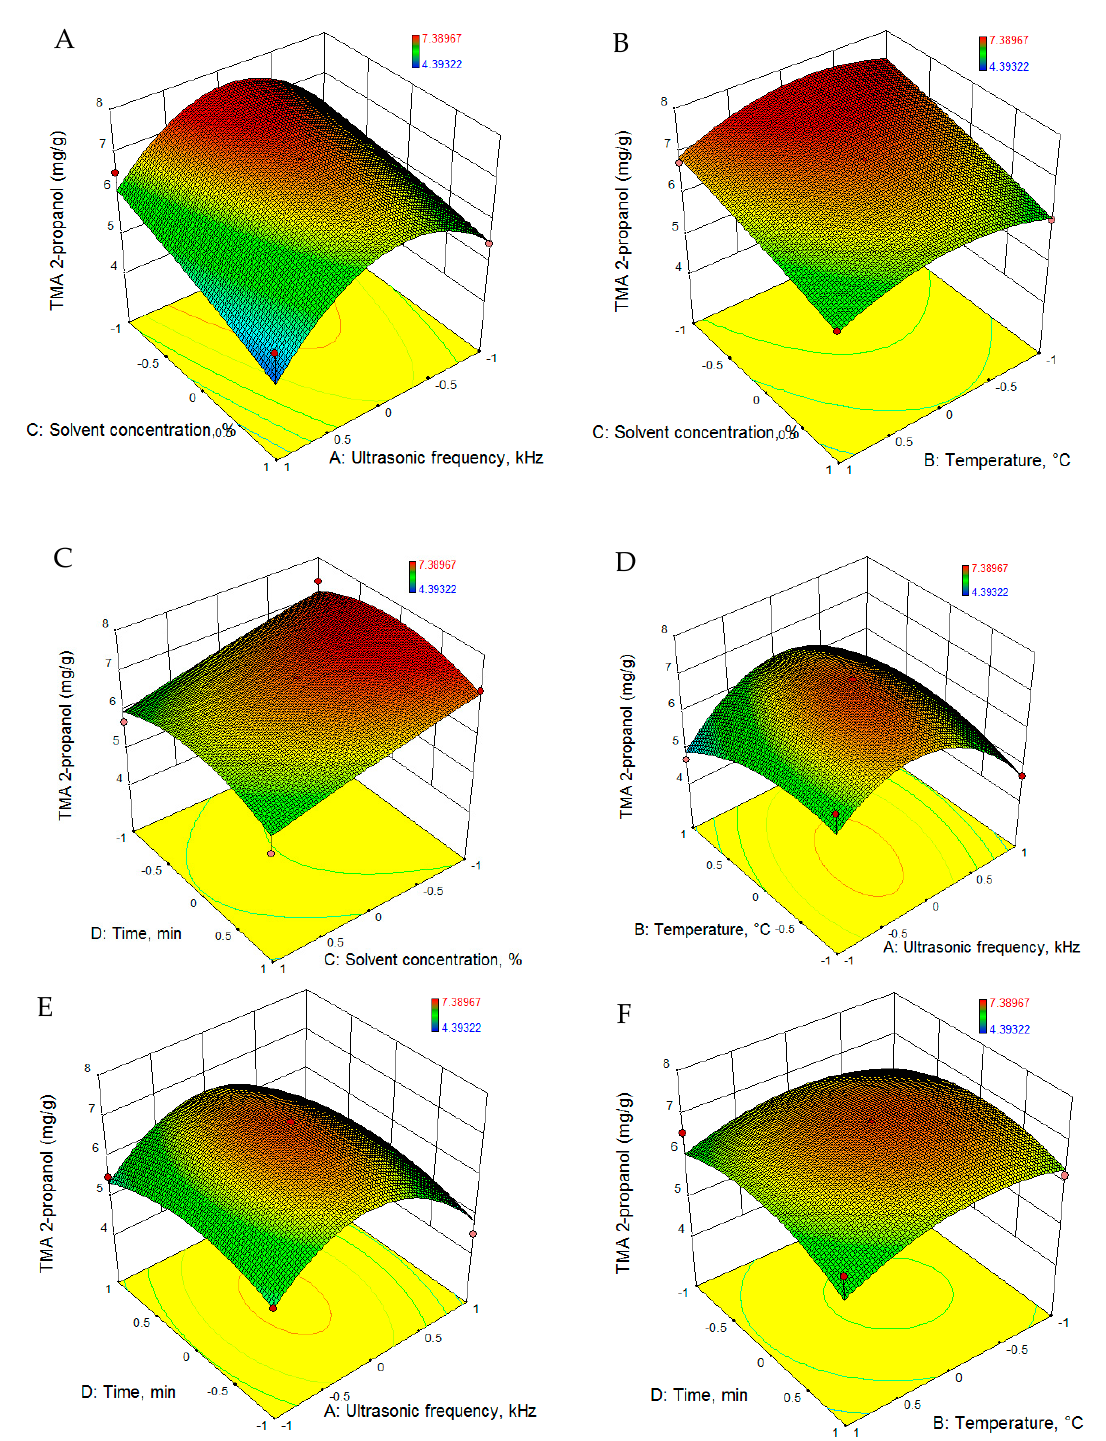
Figure 1. RSM graphs of TMA extraction evolution using 2-propanol as solvent. RSM: Response Surface Methodology, TMA: total monomeric anthocyanin.